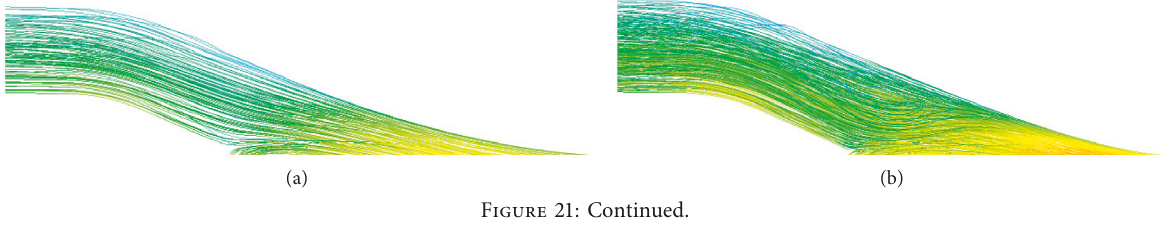
p min with different inlet passage lengths.